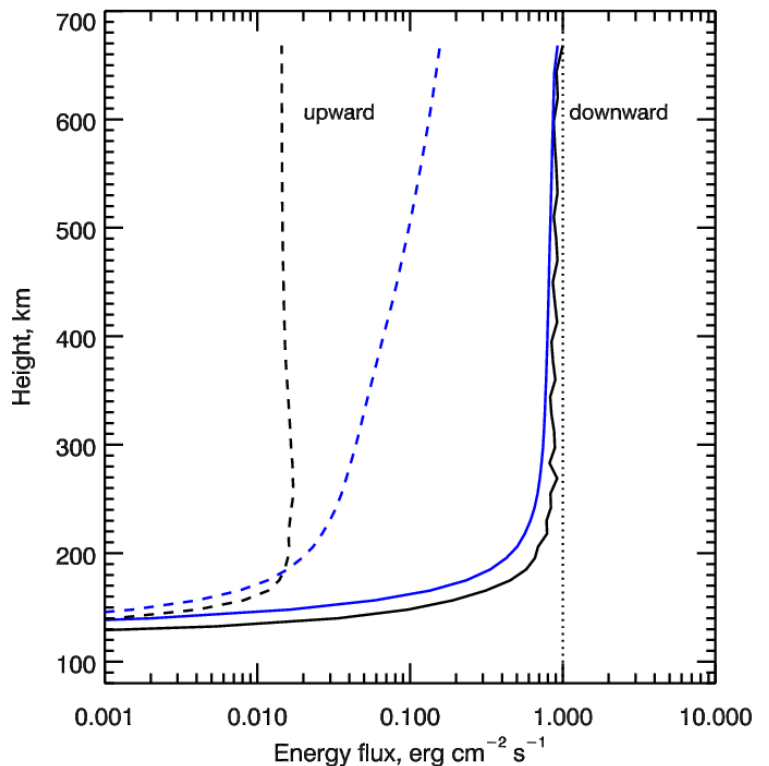
Figure 2. Height profiles of the calculated downward (solid lines) and upward (dashed lines) energy fluxes of auroral electrons. Auroral electrons precipitate as the monoenegetic flux at characteristic energy E 0 = 1 keV and are represented by monodirectional (black lines) and isotropic (blue lines) pitch-angle distributions at the upper boundary. The vertical dotted line shows the value of initial energy flux of 1 erg cm − 2 s − 1 of electrons penetrating into the upper atmosphere at height of 700 km—the upper boundary condition.